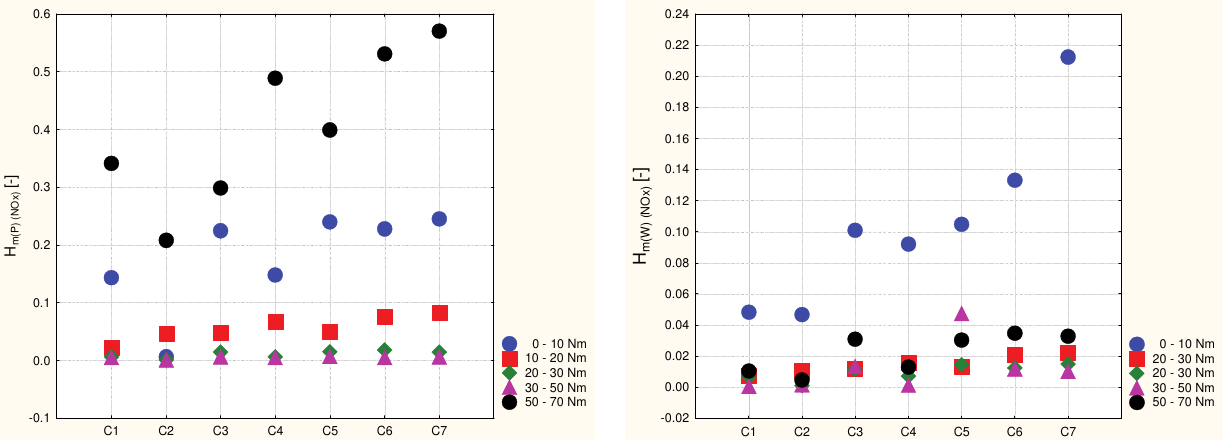
Fig. 4. Values of the information capacity index H m for NO x and the transient state at n = 1100 r/min and a change of load from T tq = 0 Nm to T tq = 70 Nm: P – delayed angle of injection advance; W – accelerated angle of injection advance; C 1 – C 7 – combinations of illustrative variables